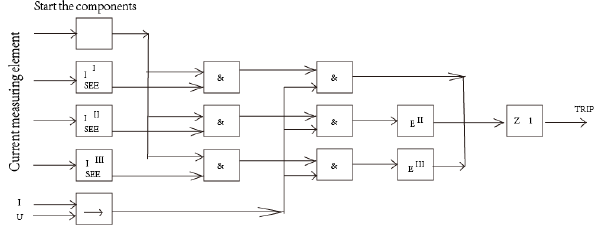
Figure 3: Action characteristics of directional current protection